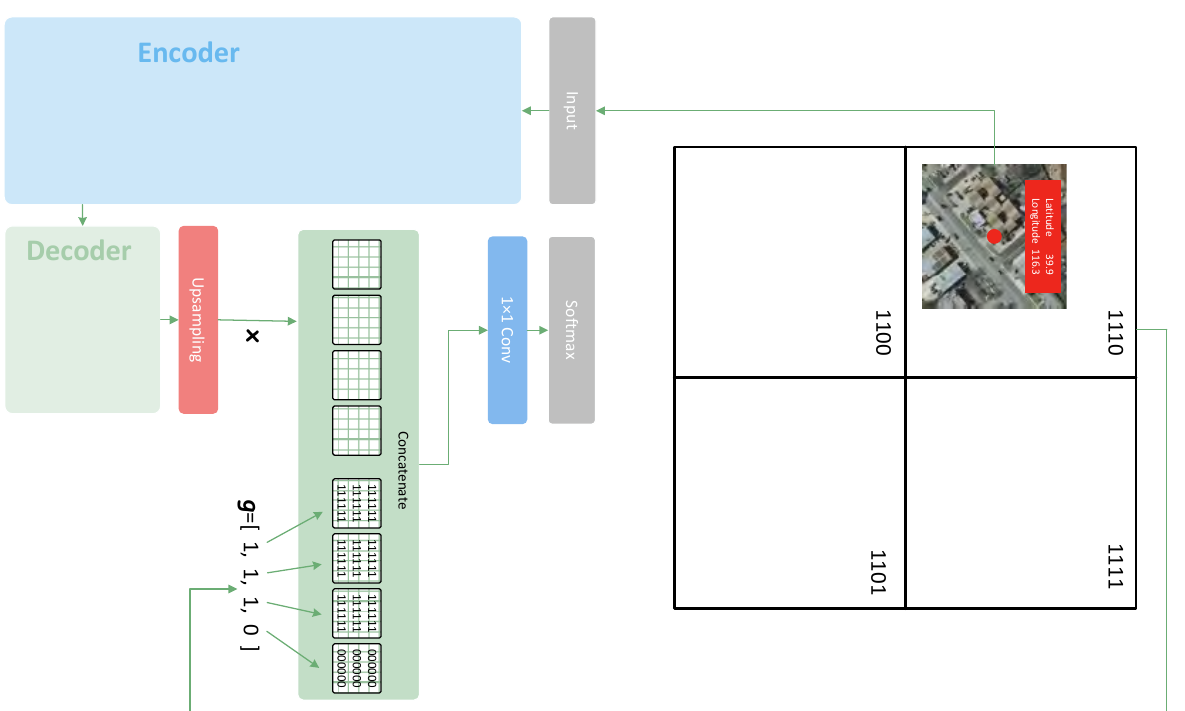
Figure 7. An example of geohash coding. First, it converts the geographic coordinates into binary bits. As shown at the top of this figure, if the center of an image tile falls into a grid, we can assign the geocode of this grid to this image. This makes the entire image tile share a common vector of the geohash code. Then, the image is fed into the convolutional neural network at the bottom. The bottom architecture is a simplified version of Figure 6, which is used for semantic segmentation. The vector of the geohash code g is resized to the size of the image feature maps x from the last upsampling layer of the network. Each bit corresponds to a channel of the geohash feature maps. Then, the image feature maps are concatenated with the geohash feature maps, and they form the input of the last convolutional layer together.